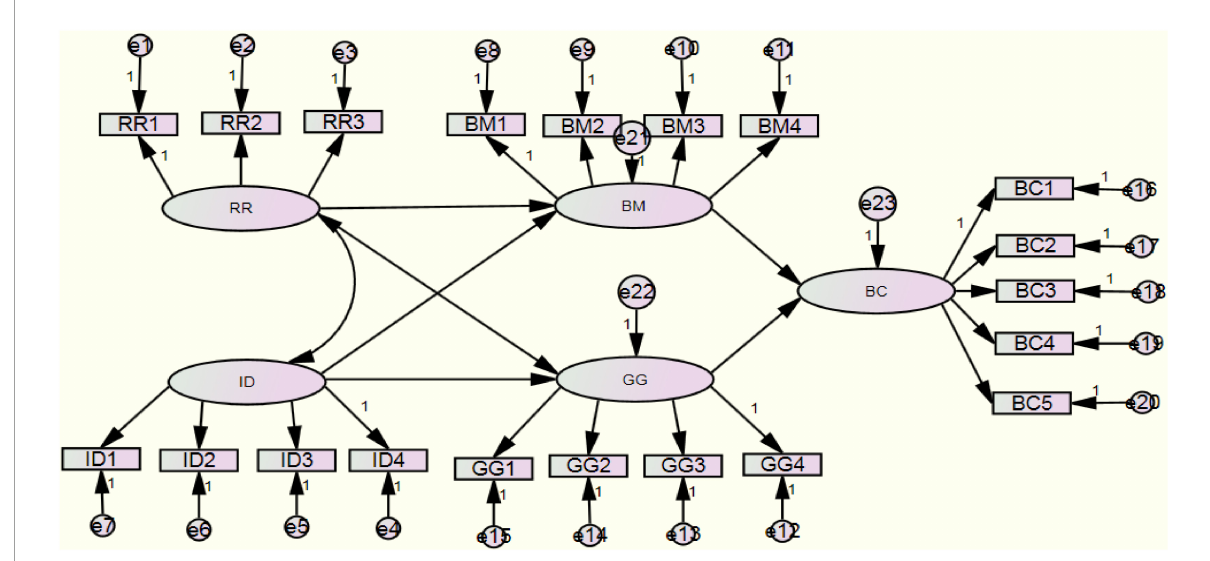
FIGURE2 Structural equation modeling (SEM) model of a causal relationship in regional BC of traditional advantageous characteristic agricultural